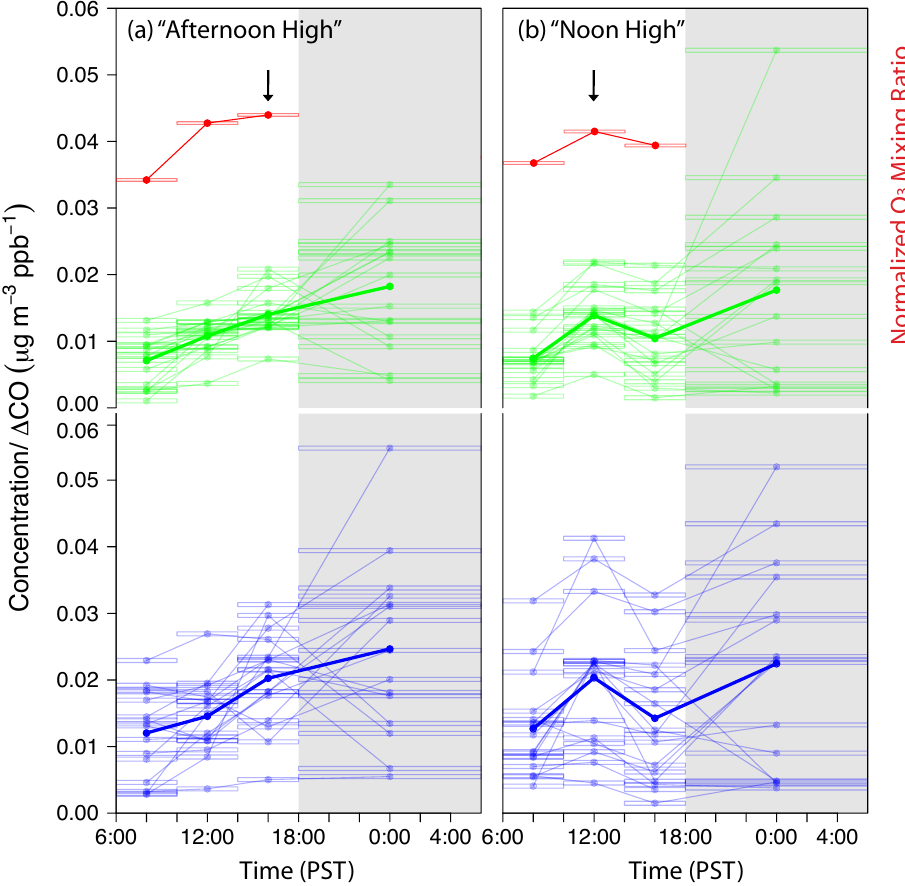
Fig. 4. Diurnal cycles of normalized carboxylic acid group concentrations (green; top part in each panel) and alkane group concentrations (blue; bottom part in each panel) divided into (a) “Afternoon High” and (b) “Noon High” types. Each rectangle represents one FTIR sample with the length of the rectangle indicating the sampling duration. The lines connecting the rectangles show samples collected in the same day. The thinner rectangles and lines represent daily diurnal profiles, while the thicker lines show the averages for the days in the corresponding panel. The red dashed lines represent average diurnal profiles of normalized O 3 mixing ratio for the days in each panel. The arrows indicate daytime peak concentration in each panel. Shaded areas indicate nighttime periods corresponding to the FTIR nighttime samples, which were excluded from the diurnal cycle